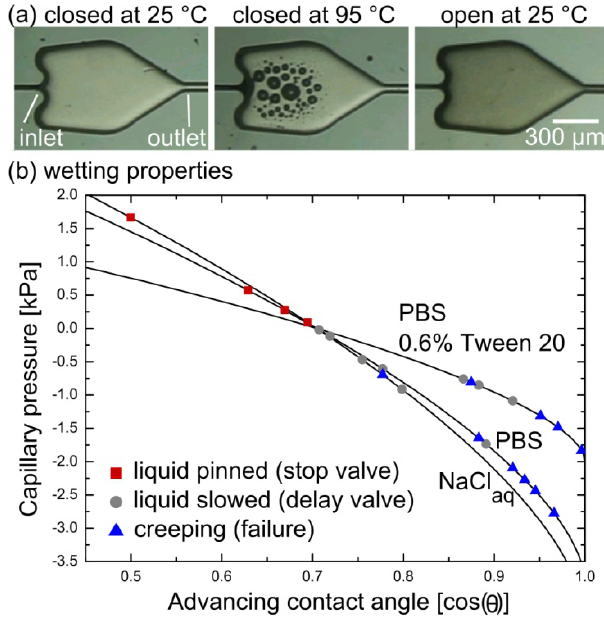
Figure 2. Performance of CSVs in varying experimental conditions. ( a ) CSVs in closed state at ambient temperature and at 95 °C, and in open state at ambient temperature. ( b ) Influence of the contact angle of a liquid filling a microfluidic chip on the performance of the CSV. Several different surface chemistries for the microfluidic chips and liquids having different surface tensions were tested. The capillary pressure barrier of the CSV was simulated and related to the filling behavior of liquids observed